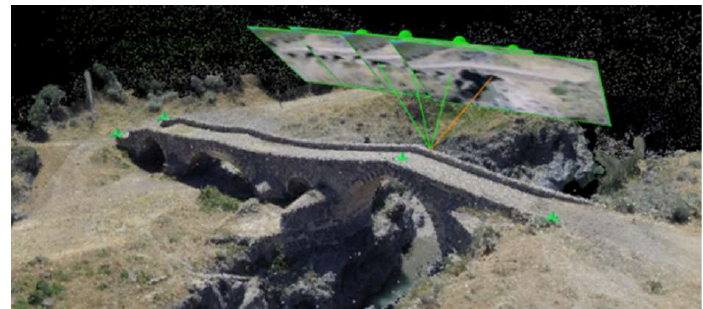
Figure 4. C ommon keypoint in three sequentially captured images in EG at ℎ (cid:3049) = 30 m.